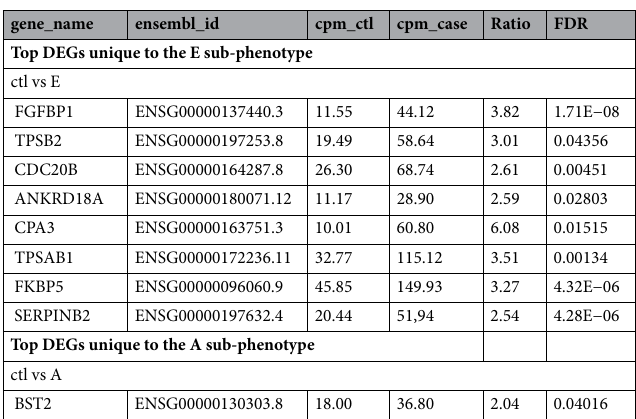
Table 2. Top and informative differential genes unique to E and A sub-phenotypes of female COPD. Given are the unique DEGs in either E and A sub-phenotypes of COPD (see Table S4C and S5 for further detail). E = emphysema-dominant, A = airway disease-dominant, For resolution of E and A into extreme and median, upper and lower quartile see Table